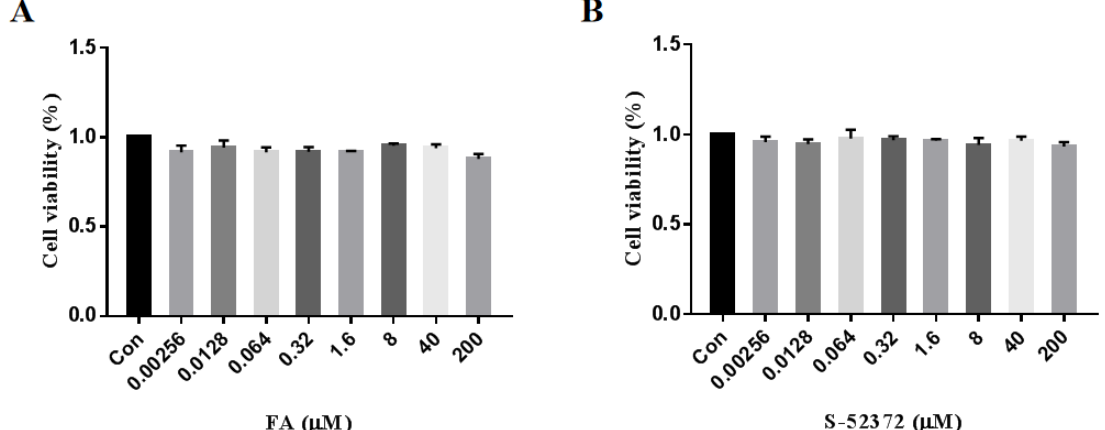
Figure 5. Cytotoxicity of ferulic acid and its derivative, S-52372, on RAW264.7 cells. RAW264.7 cells were treated with ferulic acid and S-52372 for 24 h, and an MTT assay was carried to detect the cell viability. ( A ) Cytotoxicity of ferulic acid on RAW264.7 cells. ( B ) Cytotoxicity of S-52372 on RAW264.7 cells. Each bar illustrates the average ± standard deviation (SD) counted from three experiments.